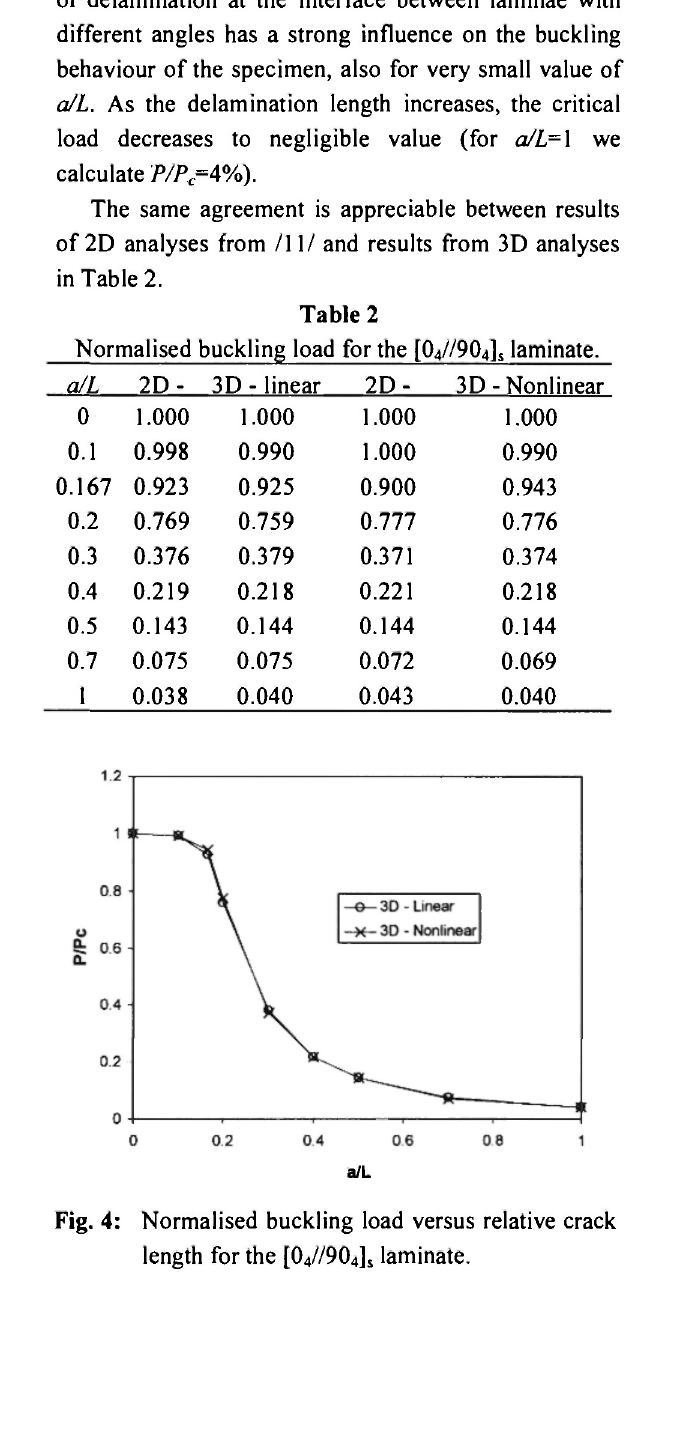
Fig. 4: Normalised buckling load versus relative crack length for the [0 4 //90 4 ] s